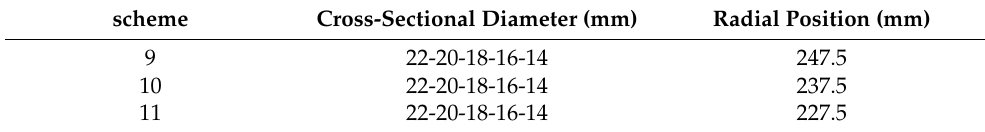
Table 4. Stator ventilation schemes with varying radial